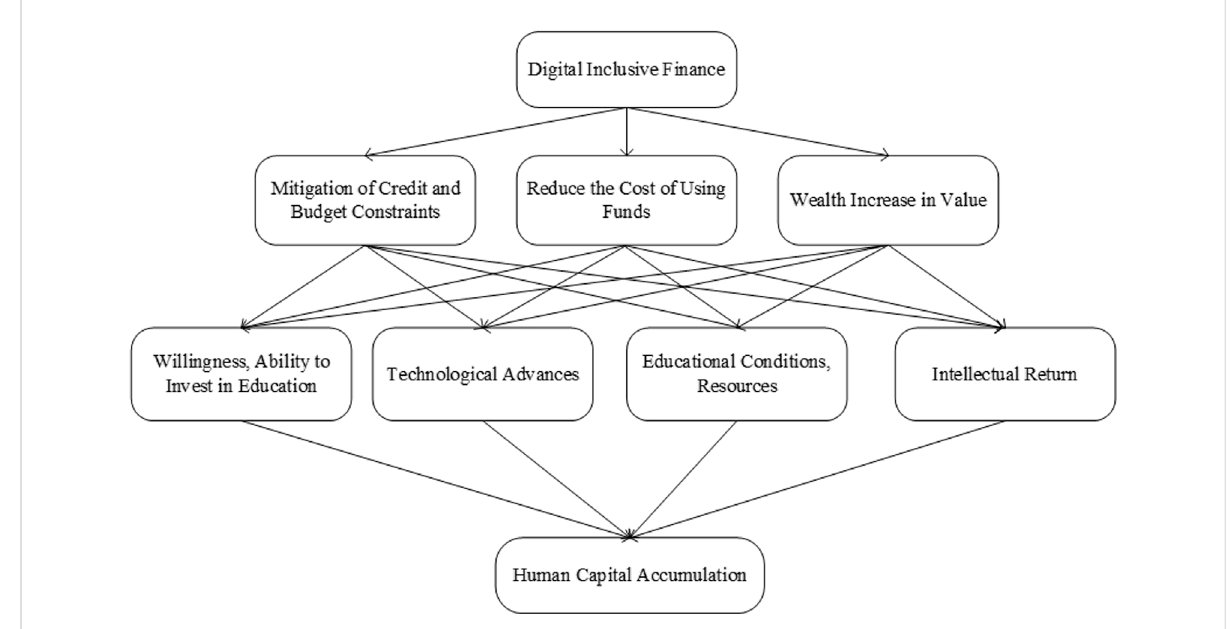
FIGURE 1 Diagram of the pathway of digital inclusive fi nance impacting rural human capital accumulation. Source: Drawn by the author.